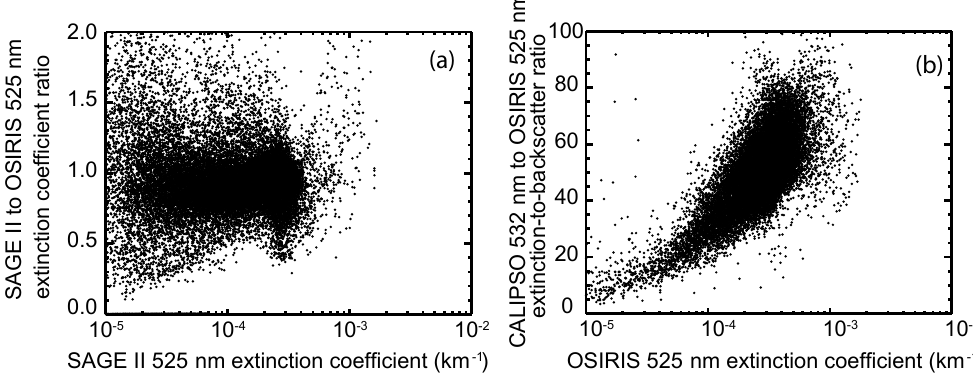
Figure 13. (a) Scatter plots of observations that show the SAGE II to OSIRIS 525nm aerosol extinction coefficient ratio where both exist in the GloSSAC data set. The average value is about 0.88. (b) Scatter plots of observations that show the CALIPSO 532nm aerosol backscatter coefficient to the scaled OSIRIS 525nm aerosol extinction coefficient ratio where both exist in the GloSSAC data set. The average value is about